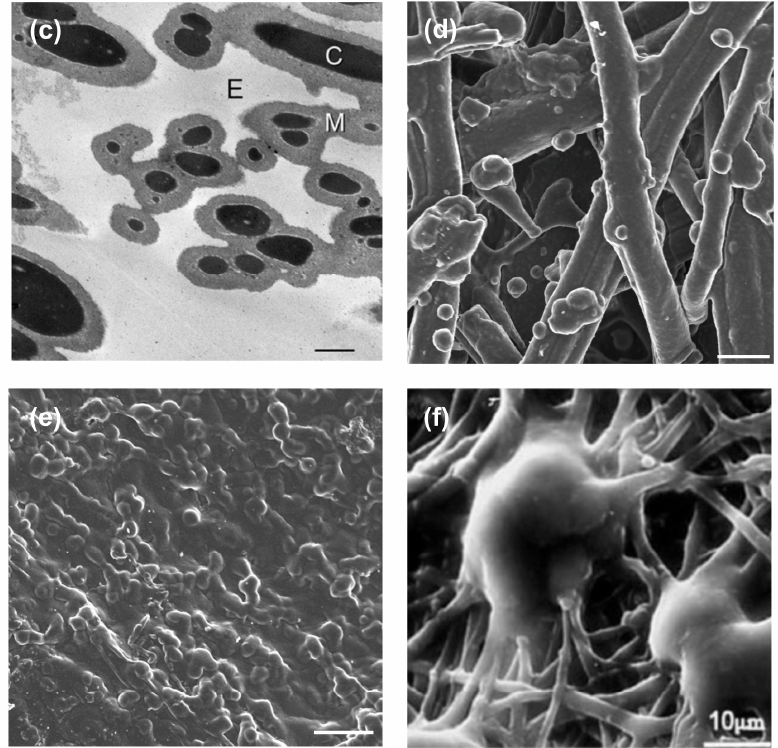
Figure 3. Eggshell membrane structure. ( a ) SEM micrograph of membrane and mammillary columns/bodies interface. It is possible to differentiate the inner shell membrane (ISM) from the outer shell membrane (OSM). The mammillary bodies (MB) are also marked, scale bar 20 µ m. ( b ) Detail of the inner membrane (ISM) and the limiting membrane (LM), scale bar 2 µ m. Figures ( a , b ) are re- produced from Hincke et al. [95]. Copyright from ELSEVIER (License number 5443170652149). ( c ) TEM micrograph of outer membrane fibers, depicting the highly electron-dense collagen- containing core (C) and the less electron-dense glycoproteic mantle (M), separated by extra-fiber spaces (E) Figure reproduced from Li et al. [96] Copyright ELSEVIER (License number 5443170450243). ( d ) View from the outer membrane surface, scale bar 2 µ m. Original images. ( e ) View from the inner surface of the shell membranes, scale bar 4 µ m. Original images. ( f ) Mammillary knobs before calcification], scale bar ∼ 10 µ m. Figure reproduced from Arias et al. [97] Copyright WILEY-VCH Verlag GmbH & Co. KGaA (License number